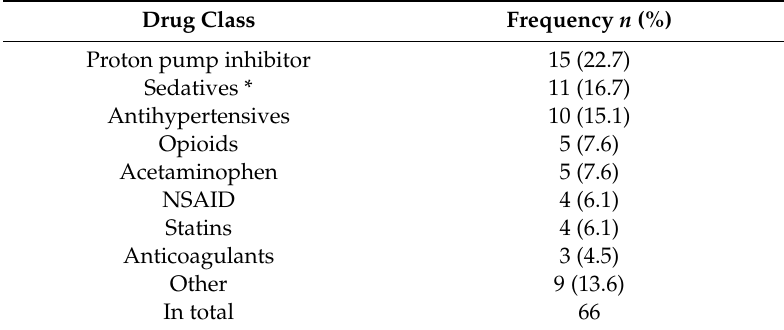
Table 4. Most frequently deprescribed